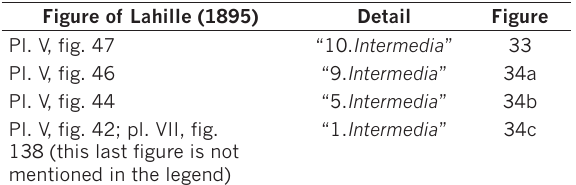
Table 12. Voluta colocynthis intermedia , specimens figured by Lahille (1895), with the detail of the inscriptions on their shells and figures here.